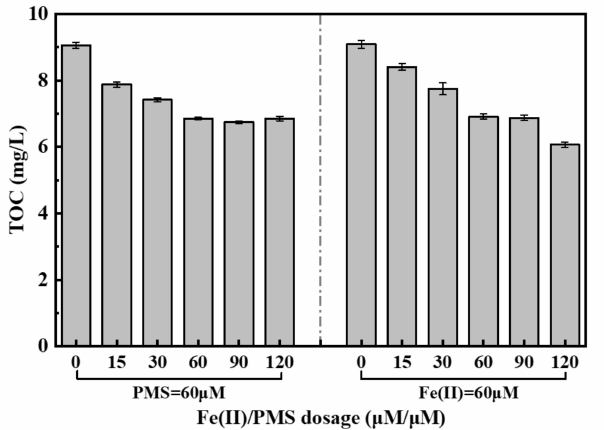
Figure 2. Pollutants in the feed water of UF under different molar ratios of Fe(II)/PMS: concentrations of